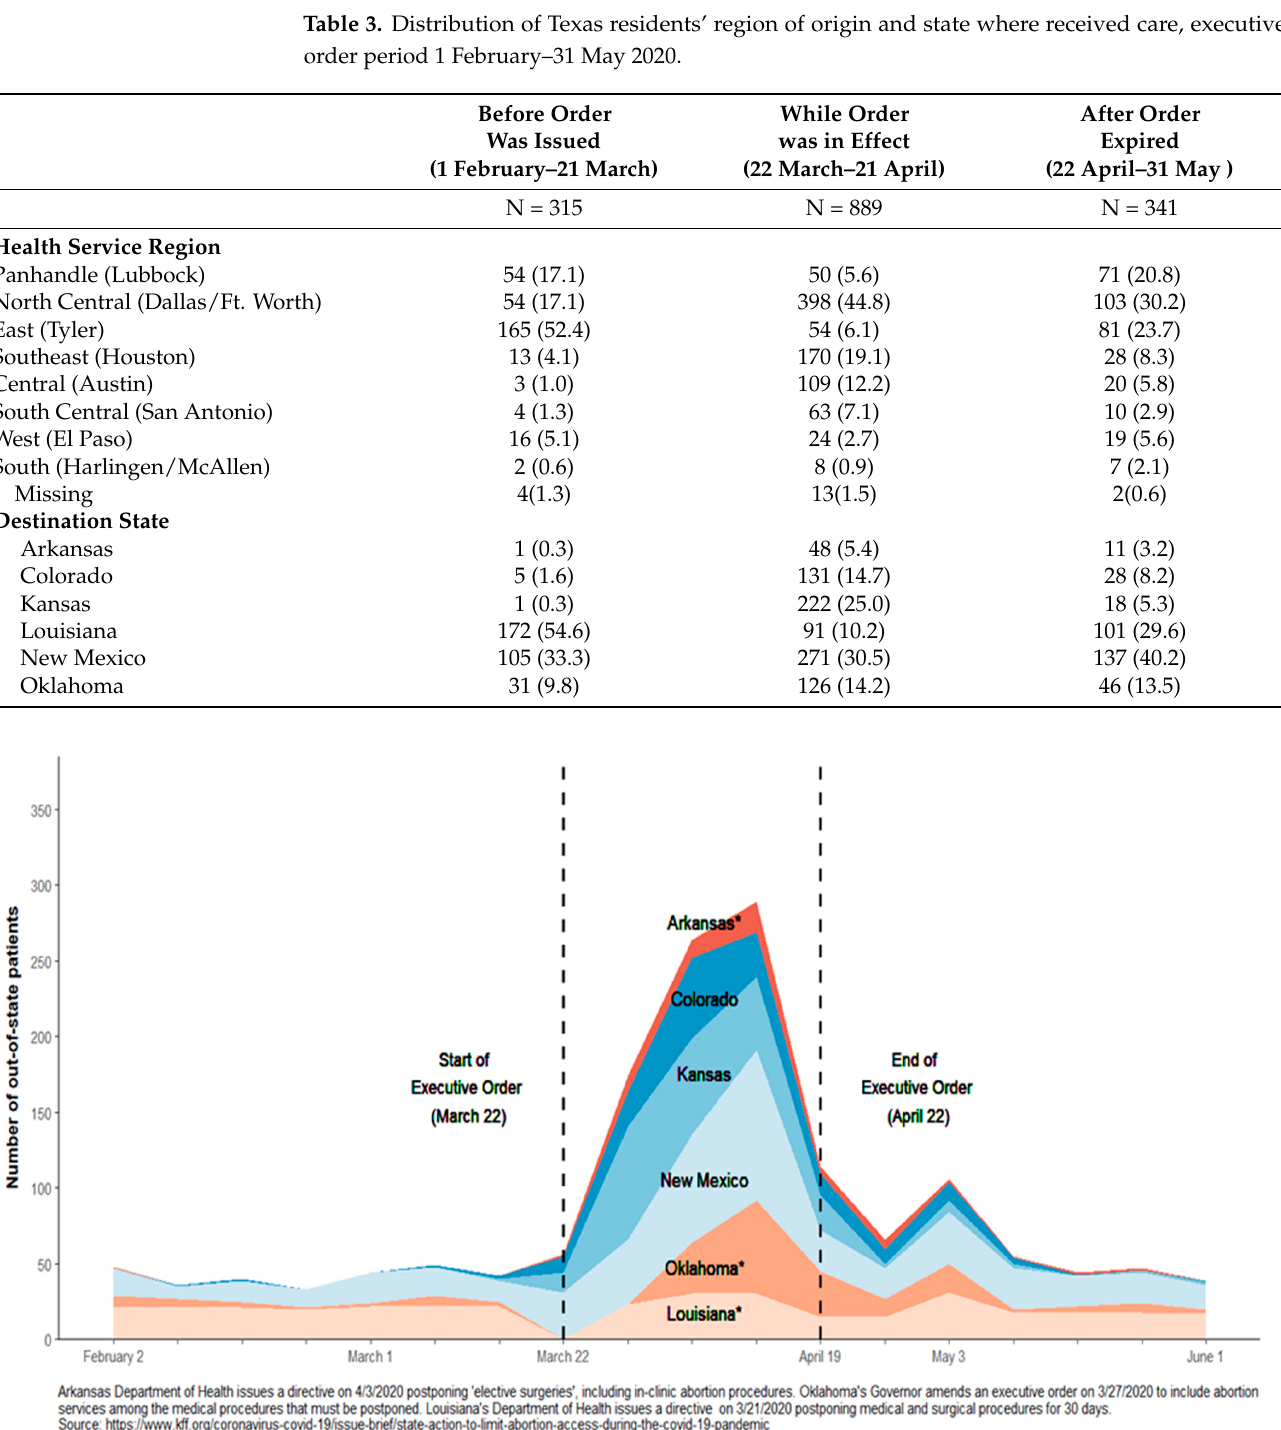
Figure 4. Weekly volume of Texas residents who obtained out-of-state abortion care, by state. During the executive order, the median one-way distance traveled was 189 miles (IQR: 98 to 240 miles) for Texas residents who obtained care at the nearest out-of-state facility, 155 miles further than the median travel distance before the executive order (Table 4). The median one-way travel distance was 468 miles (IQR: 335 to 737 miles) for those whose nearest out-of-state facility had service disruptions. Texans living in the most economically prosperous county quintiles traveled further for care than those who resided in the most distressed counties (median 403 miles versus 289 miles, p < 0.001). Texans who obtained care between 16 and 21 weeks of gestation traveled a median of 627 miles one way (IQR: 366 to 811); those who had a gestational duration of ≤ 11 weeks traveled 384 miles (IQR: 279 to 694). People who obtained abortions ≥ 22 weeks of gestation (beyond the Texas gestational limit) traveled a median of 689 miles one way (IQR: 649 to 855 miles), similar to the distance traveled before and after the executive order.